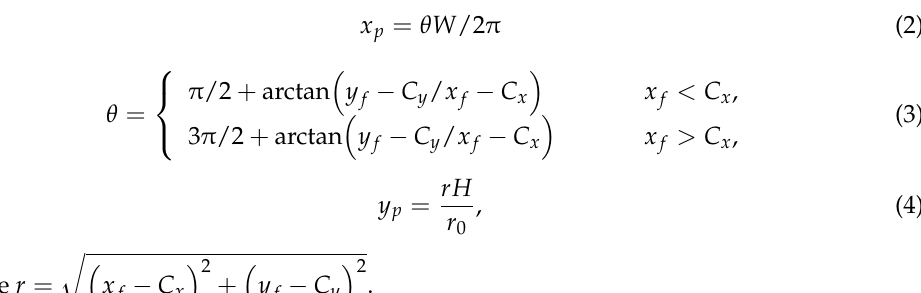
Figure 4. Transformation of cylindrical panoramic image to azimuthal fisheye image. ( a ) Top half of panorama image. ( b ) Schematic diagram of cylindrical projection. ( c ) Schematic diagram of azi- muthal projection. ( d ) Fisheye image based on azimuth projection.